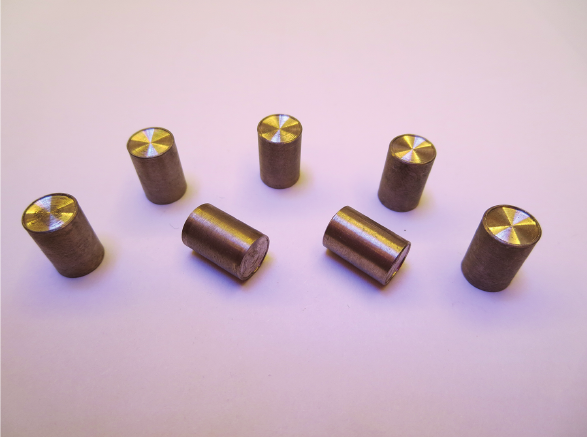
Figure 2: Typical appearance of the BFe10-1-2 cupronickel alloy